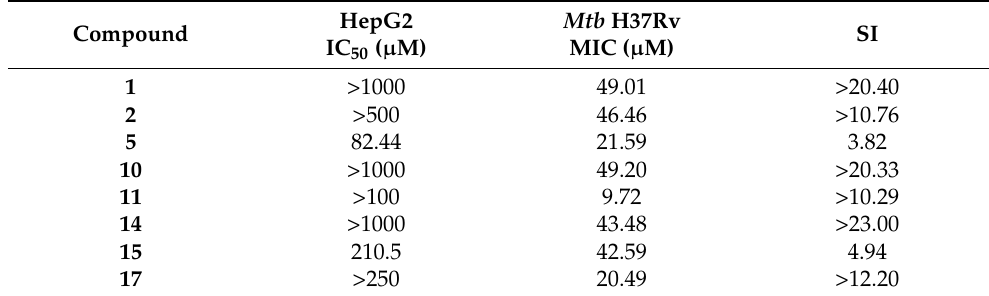
Table 3. Cytotoxicity of the selected compounds against HepG2 cell line (IC 50 ) and selectivity indices (SI) in relation to their antimycobacterial activity against Mtb H37Rv